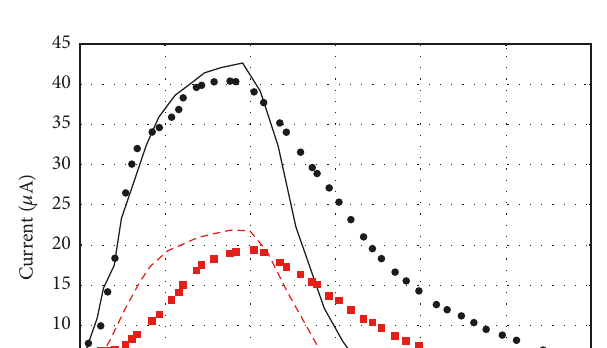
Table 6: List of species.